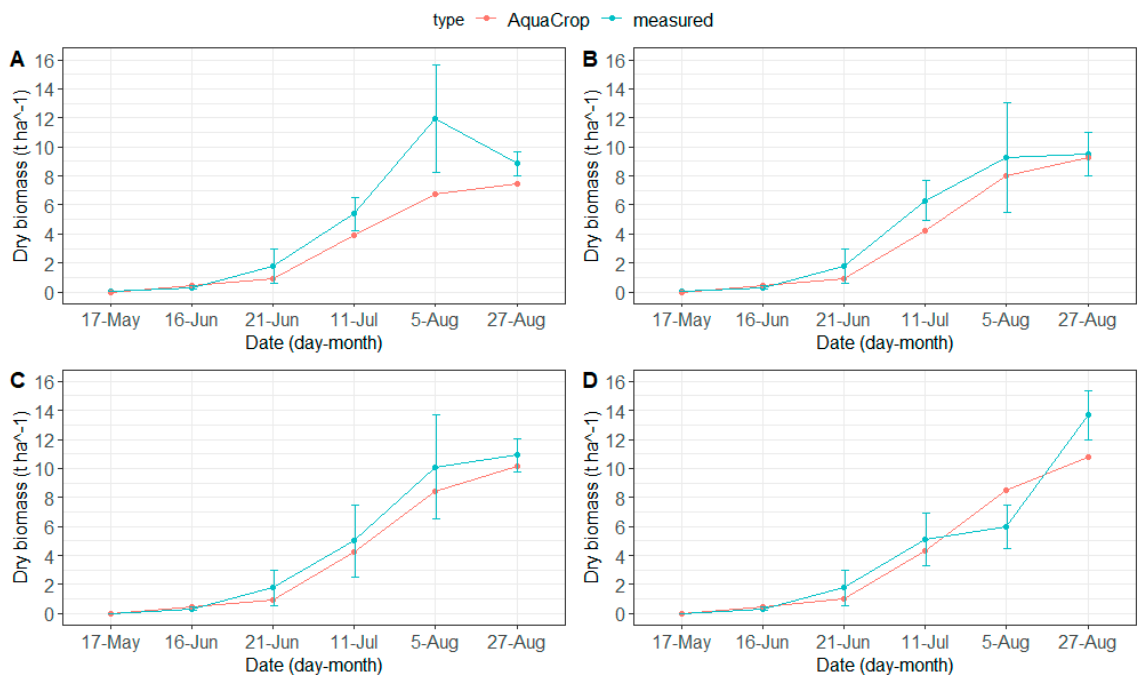
Figure 2. Simulated and measured yield values for the 2018 growing season (calibration). Error bars represent the standard deviation (n = 4). The ( A – D ) letters refer to the K, I50, I75, and I100 treatments, respectively.